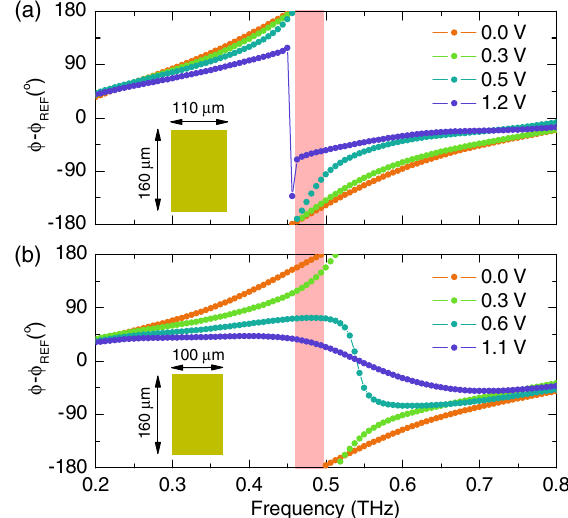
FIG. 3. Full-range gate-controlled phase modulation. Gate- dependent reflection phase spectra of (a) device A with a mesa size of 110 μ m × 160 μ m and (b) device B with a mesa size of 100 μ m × 160 μ m. For both devices, the thickness of the SU8 spacer is 60 μ m, and the mesa array has a period of 240 μ m in both the x and y directions. The incident THz wave is polarized along the short axis of the mesa. The spectrum measured on an Al mirror is used as the reference. A large phase modulation is obtained in the shaded